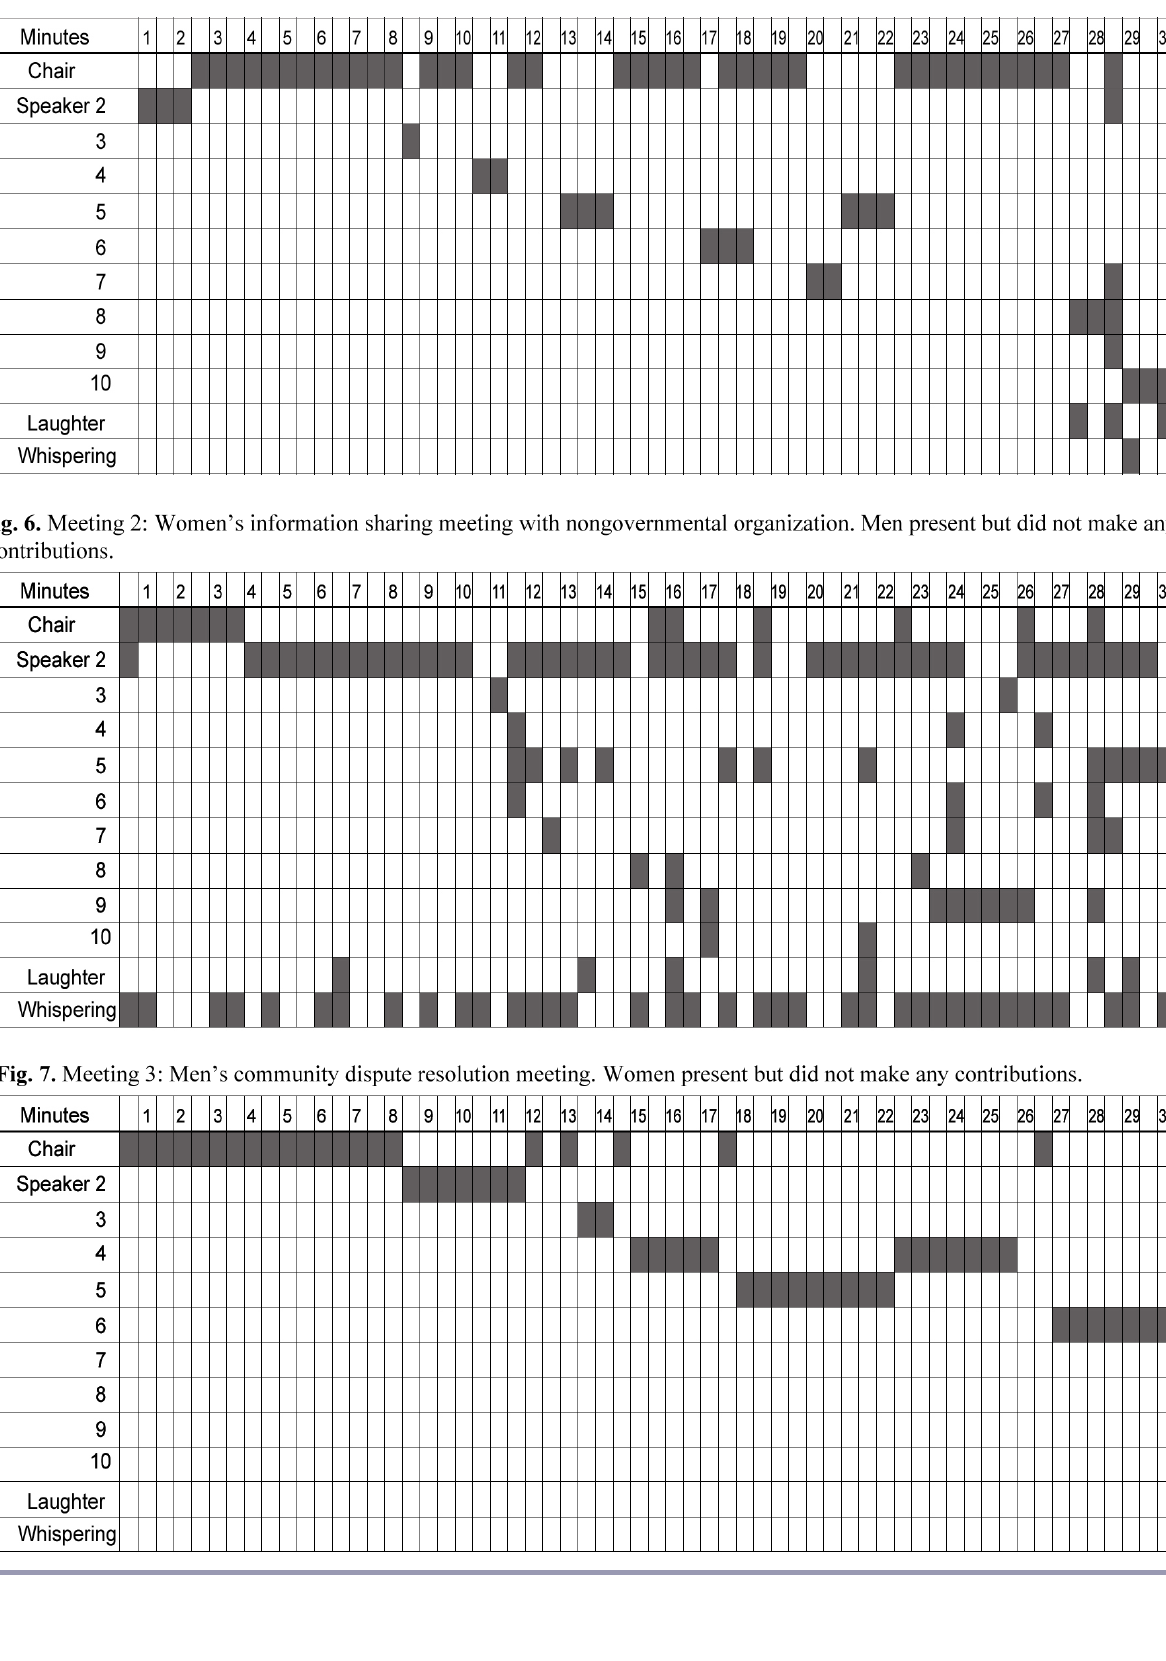
Fig. 5 . Meeting 1: Men’s information sharing meeting with nongovernmental organization. No women